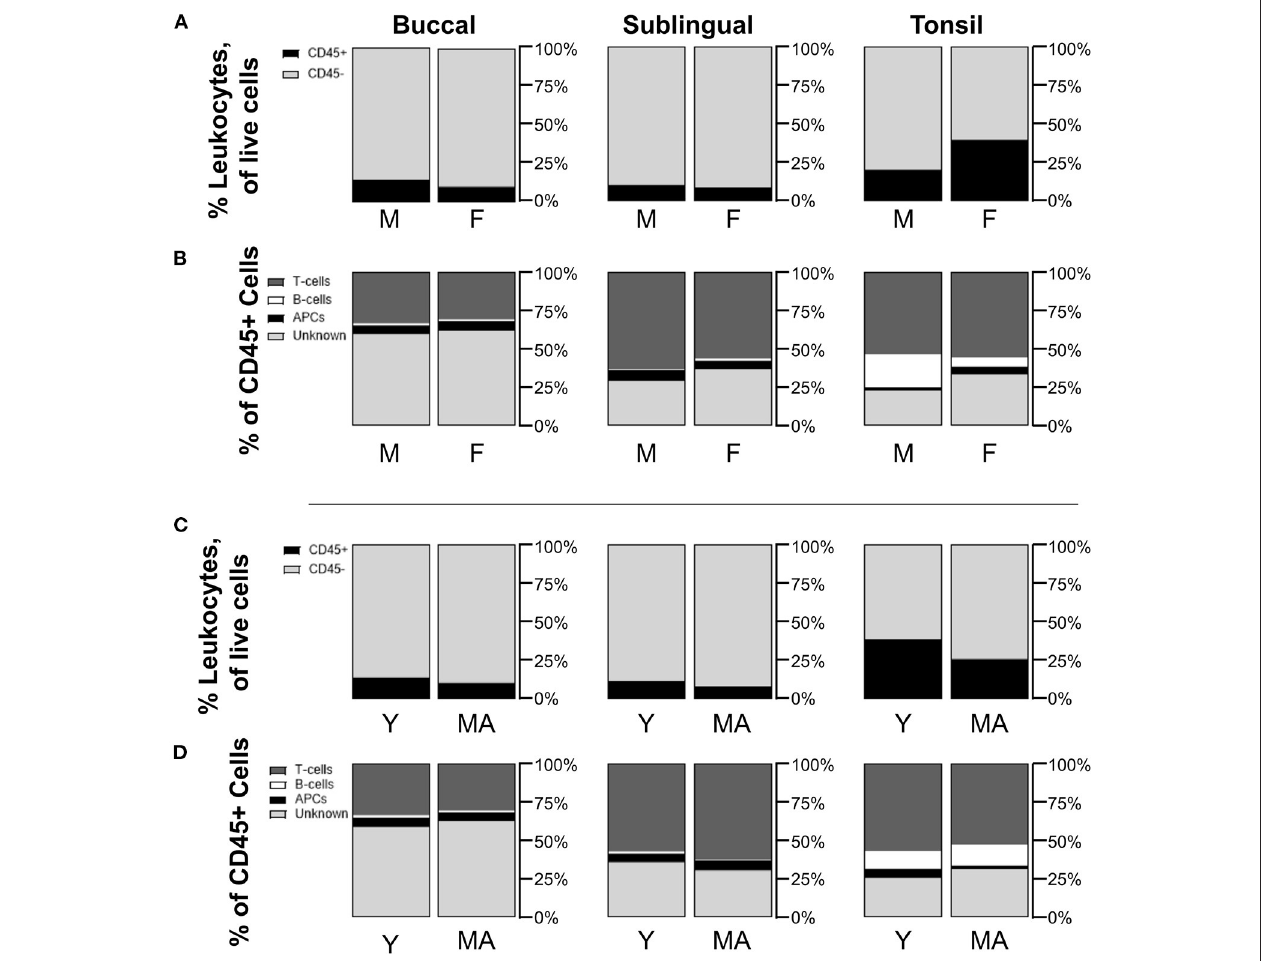
FIGURE 3 | Non-statistically significant differences are measured in immune cell populations across differences in NHP sex and age. Compositions of CD45 + /– cells in total live cells are shown by comparison between (A) male (M) and female (F) NHPs (biopsy only), and (C) young (Y, under 15 years) and mid-aged (MA, between 15 and 20 years) NHPs (biopsy only). Distributions of CD45 + subpopulations for (B) M/F NHPs and (D) Y/MA NHPs are defined as T-cells being CD45 + CD3 + , B-cells as CD45 + CD3–CD20 + , APCs as CD45 + CD3–CD20–CD11c + , and unknown immune cells as CD45 + CD3–CD20–CD11c–. Mean values of cell frequencies are used to show compositions with n = 3–4 NHPs (3M and 4F, 3 Y and